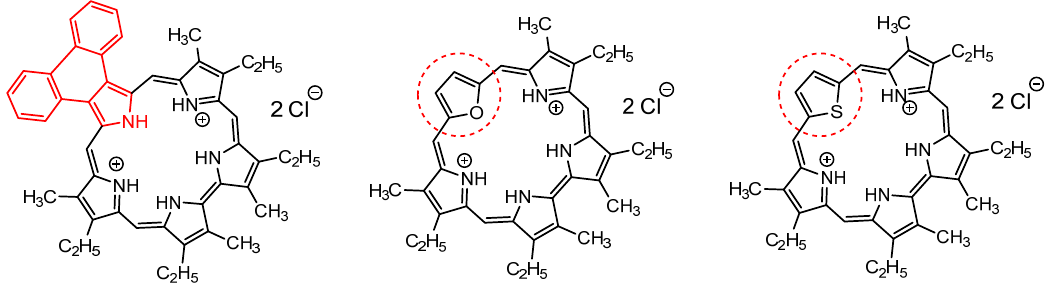
Figure 13. Molecular structures of some representative sapphyrin and heterosapphyrins tested against Leishmania tarentolae and Leishmania panamensis , by Hooker et al. [104].